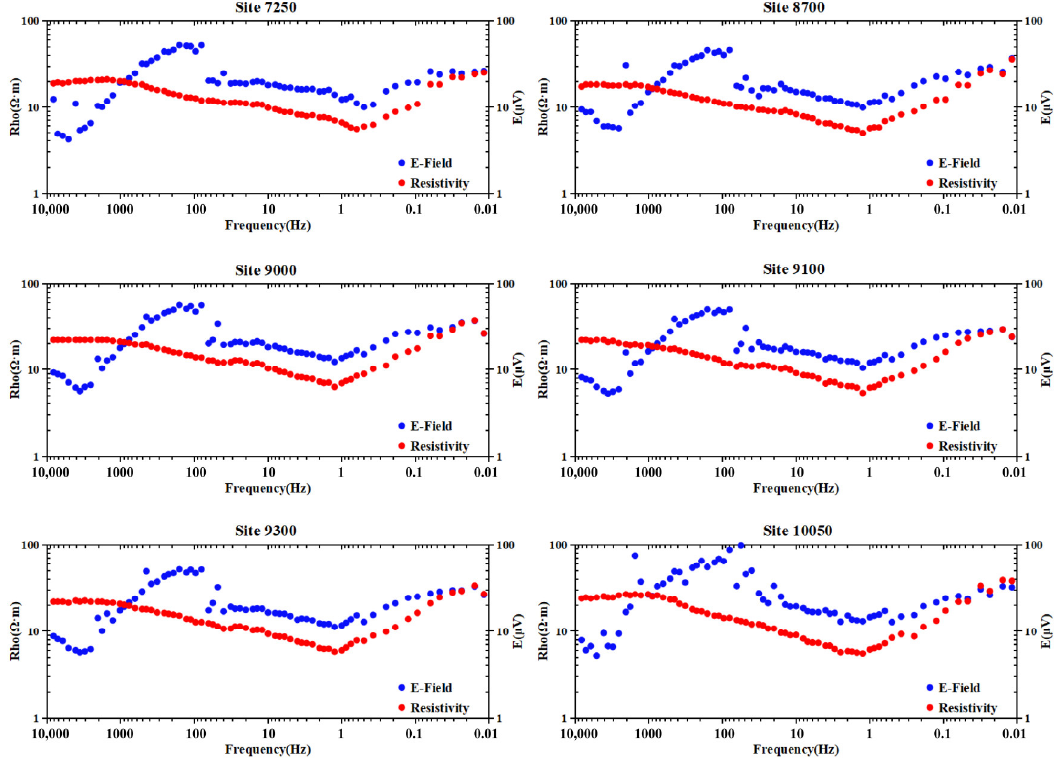
Figure 5. Frequency–electrical field–apparent resistivity curves of typical sites on profile PGY2.